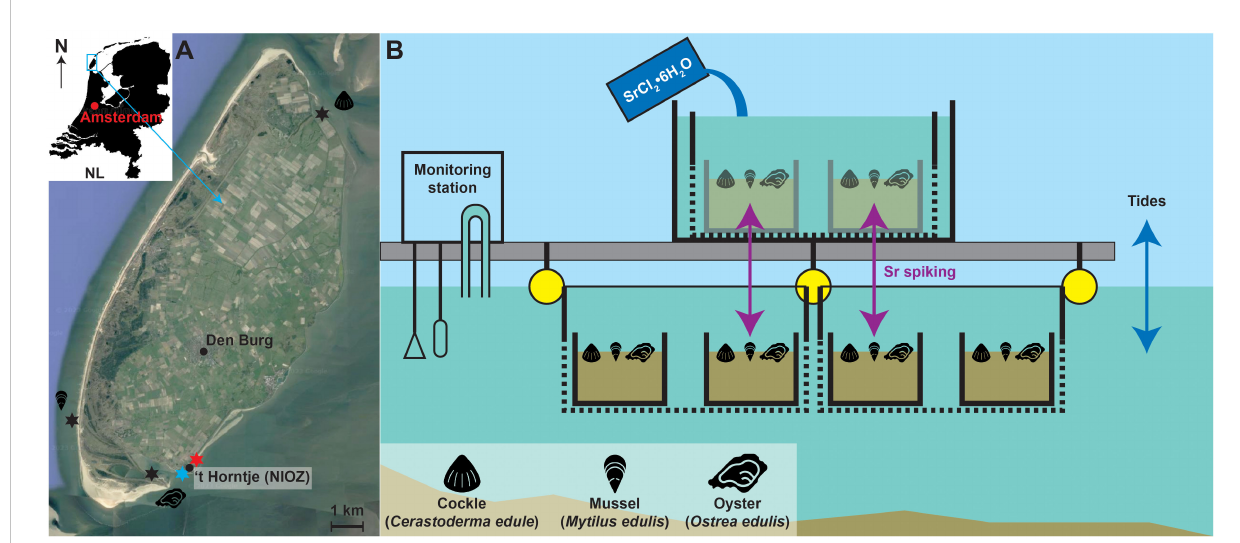
FIGURE 1 (A) Satellite image of Texel island (52°58 ’ 31 ” N, 4°41 ’ 05 ” E). Modi fi ed using Maps Data ©2023 Alphabet Inc., Mountain View, CA, USA . Round symbols indicate the location of named population centers. Stars indicate the origins of juvenile specimens (black; with symbols indicating the species), the location of the culture setup (red) and the location of the monitoring station (blue), ~600 meter away from the culturing locality. (B) Schematic overview of the experimental setup, with the fl oating jetty in grey, the crates in black and the buoys in yellow. Note that oysters and mussels were grown in nets attached to the side of the crates and not in the sand containers. Water depth is not to scale but was suf fi cient to keep the crates submerged even during the lowest tides. Purple arrows indicate the transfer of specimens to environments with elevated Sr concentrations during the spiking